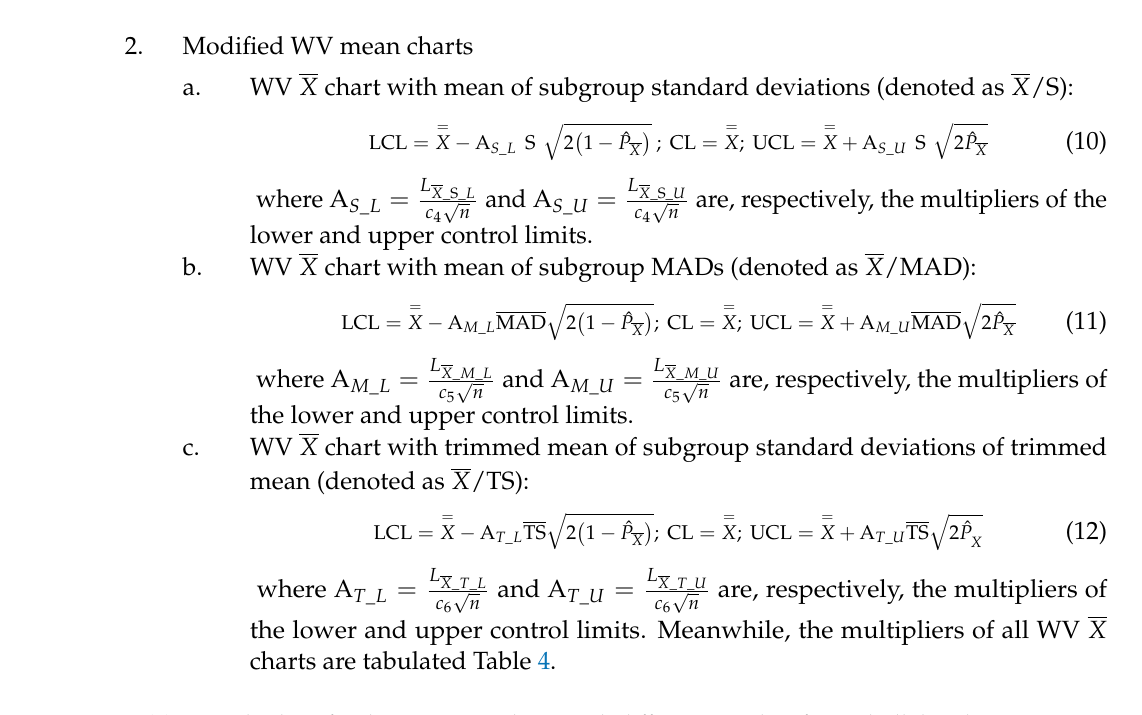
Table 4. Multipliers for the WV mean charts with different n and κ of a Weibull